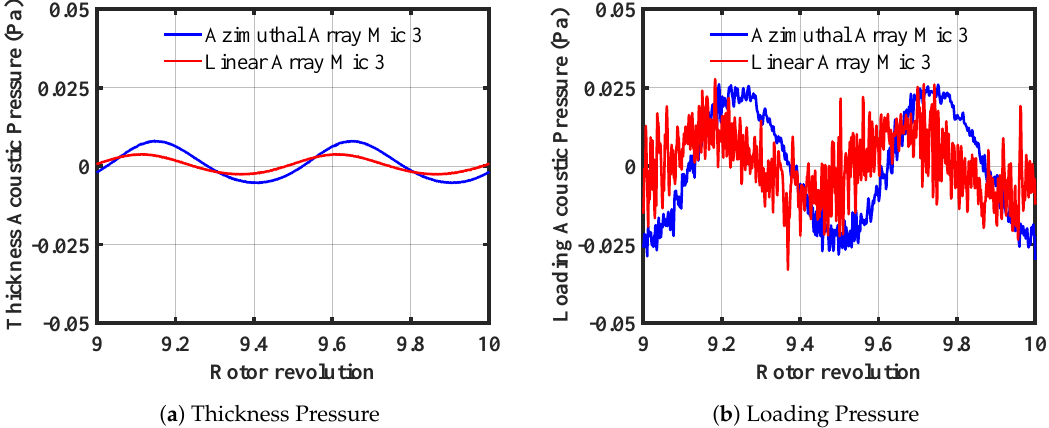
Figure 15. Thickness and loading acoustic pressure signals computed using Helios/PSU-WOPWOP of the isolated rotor in hover over the final rotor revolution. Mic 3 of the azimuthal array is plotted in blue, while mic 3 of the linear array is plotted in